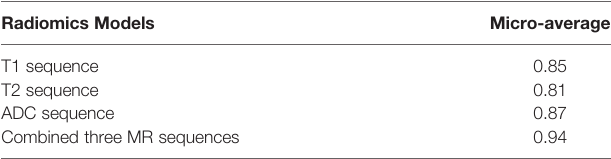
TABLE 4 | Classi fi cation performance of four models for GIST risk level.